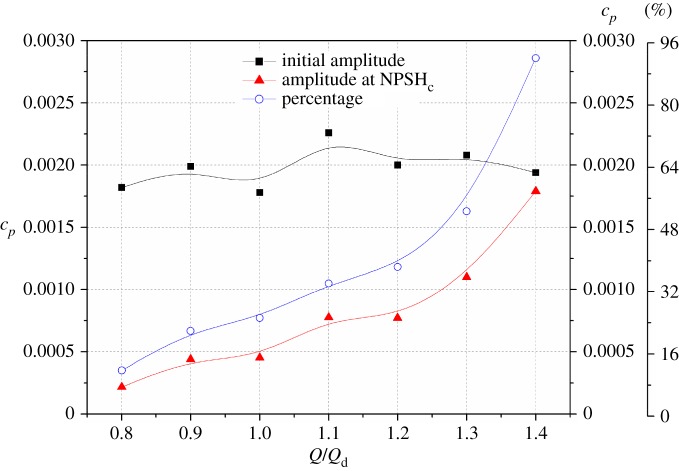
Comparison of amplitudes at fBPF for In1 under non-cavitation and critical point NPSHc conditions.